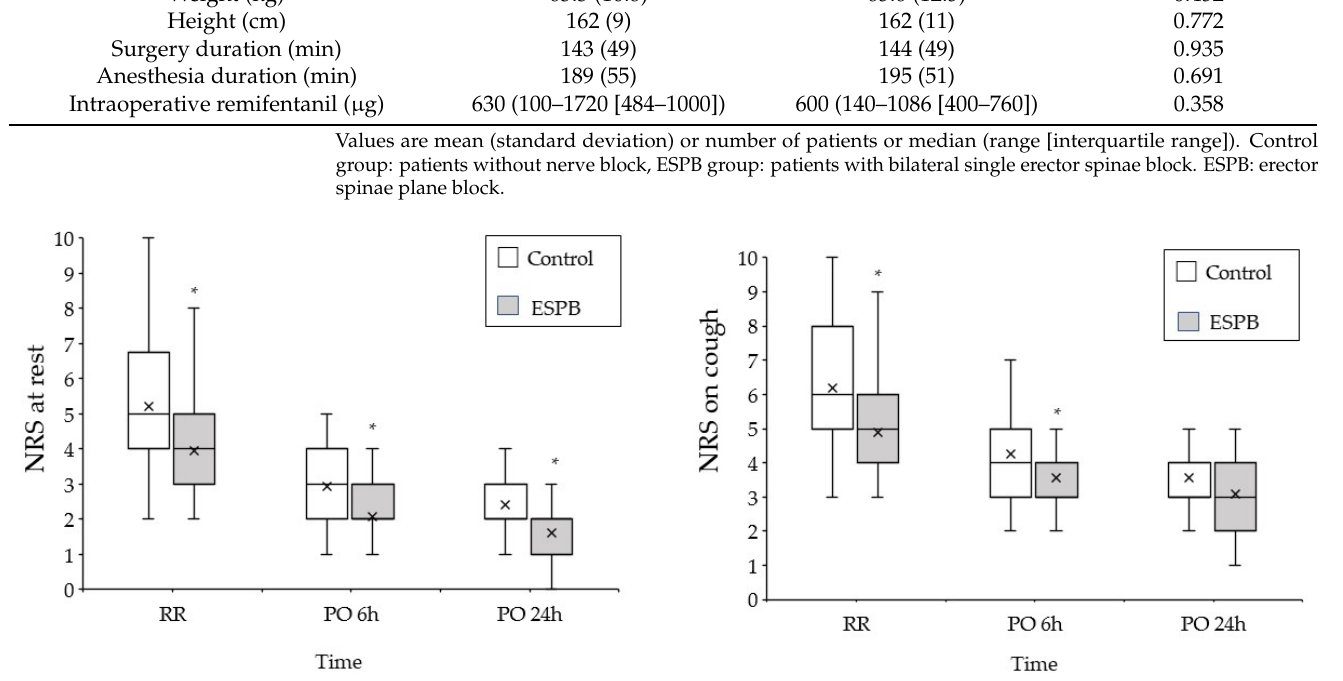
Figure 2. Pain scores at rest and on cough in the recovery room, and at 6 h and 24 h after the surgery. Control group: patients without nerve block, ESPB group: patients with bilateral single erector spinae plane block. ESPB: erector spinae plane block, NRS: 11-point numeric rating score from 0 (no pain) to 10 (worst pain imaginable). RR: recovery room, PO 6 h and 24 h: 6 h and 24 h after the surgery, respectively. Box, the line in the box, X and error bar mean interquatile range, median, mean